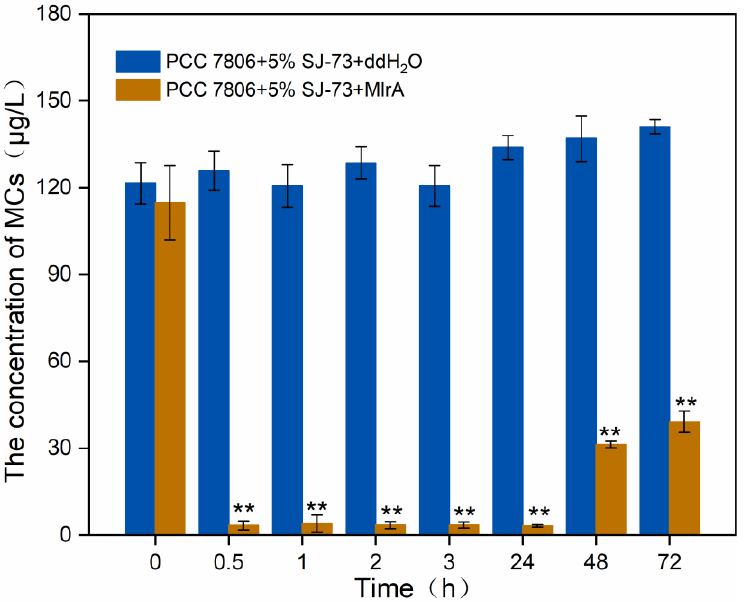
Figure 6. Changes on the concentration of extracellular MCs in M. aeruginosa PCC 7806 culture treated with 5% bacteria SJ-73 filtrates and 0.8 mg/L MlrA. Bars represent the standard errors of the means for triplicate. Significant differences are shown by asterisks: **, p < 0.01.